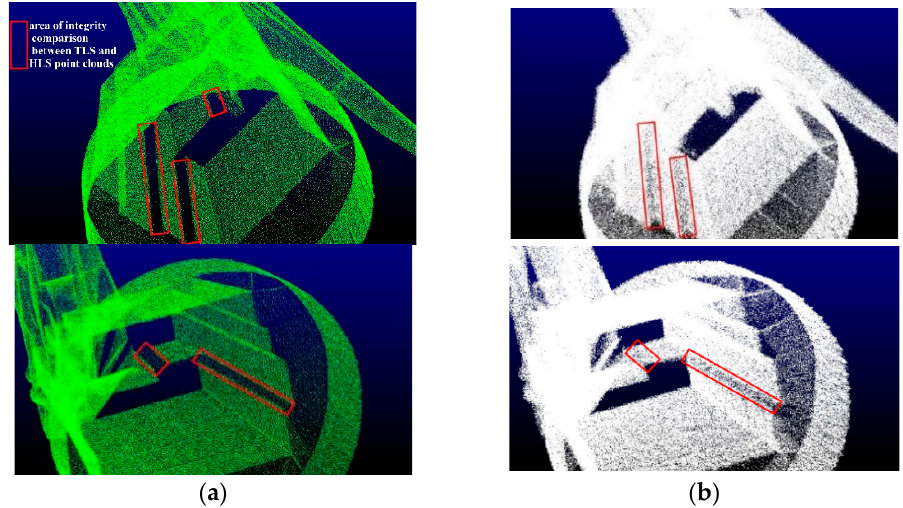
Figure 9. Data integrity comparison between TLS and HLS point clouds. ( a ) TLS partial point cloud. ( b ) HLS partial point cloud.